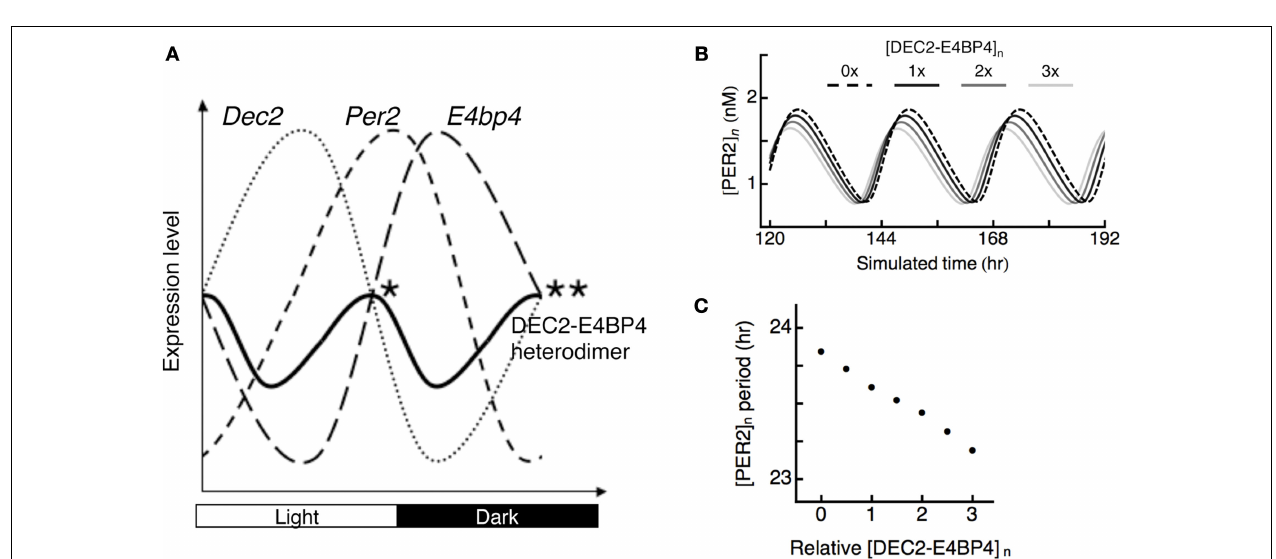
under various amounts of DEC2–E4BP4 heterodimer. Oscillations of PER2 expression levels under various amounts of [DEC2–E4BP4] n ( n = 0, 1, 2, 3) are indicated with dashed line ( n = 0), black solid line ( n = 1), gray solid line ( n = 2), and light gray line ( n = 3). The simulated nuclear concentration of DEC2–E4BP4 heterodimer ([DEC2–E4BP4] n ) induces phase advance of PER2 ([PER2] n ) expression cycling in a concentration-dependent manner. (C) Periods of the PER2 oscillations under various amount of DEC2–E4BP4 heterodimer in (B) . High concentration of DEC2–E4BP4 heterodimer shortens the period of PER2